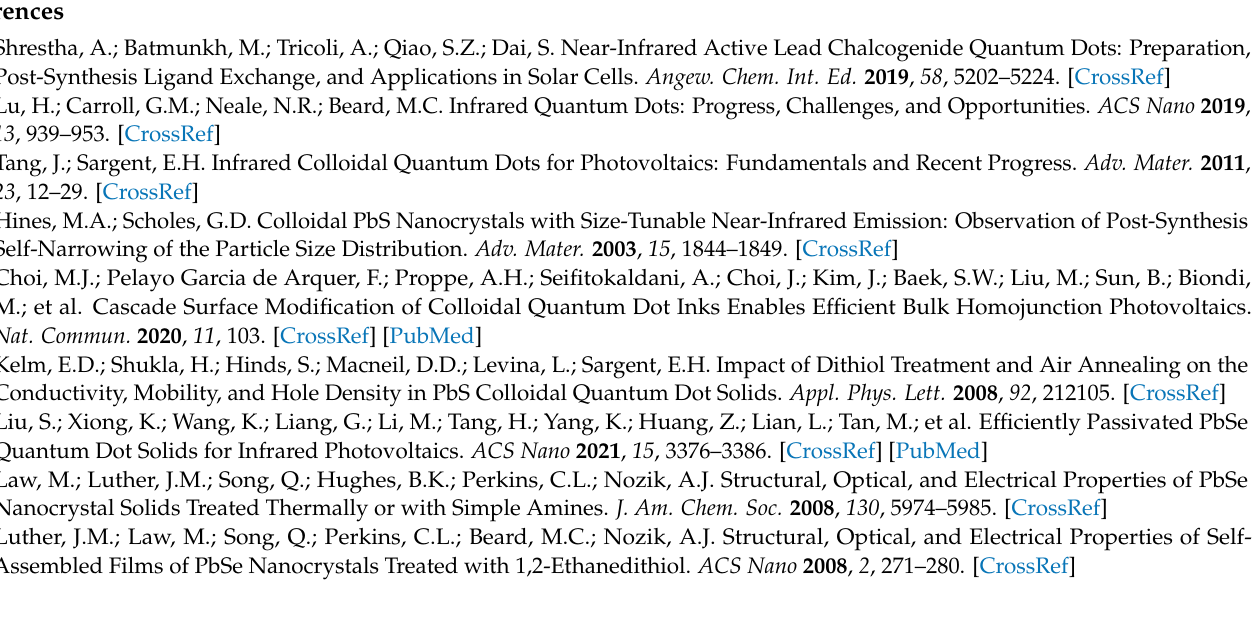
Figure S1: (a) − (e) Histogram of size distribution of PbS 1 − x Se x QDs; Figure S2: (a) − (e) The fitting results of absorption spectra for PbS 1 − x Se x QDs; Figure S3: Photocurrents measured at different times as a function of x value in PbS 1 − x Se x -QDs@MWCNT/P3HT; Figure S4: (a) − (e) Cyclic voltammetry (CV) tests of PbS, PbS 0.50 Se 0.50 , PbS 0.25 Se 0.75 , PbSe QDs and P3HT, and (f) the absorption spectrum of P3HT; Table S2: Synthesis parameters of PbS 1 − x Se x QDs; Table S3: Atomic ratio of S/Se in PbS 1 − x Se x QDs measured by